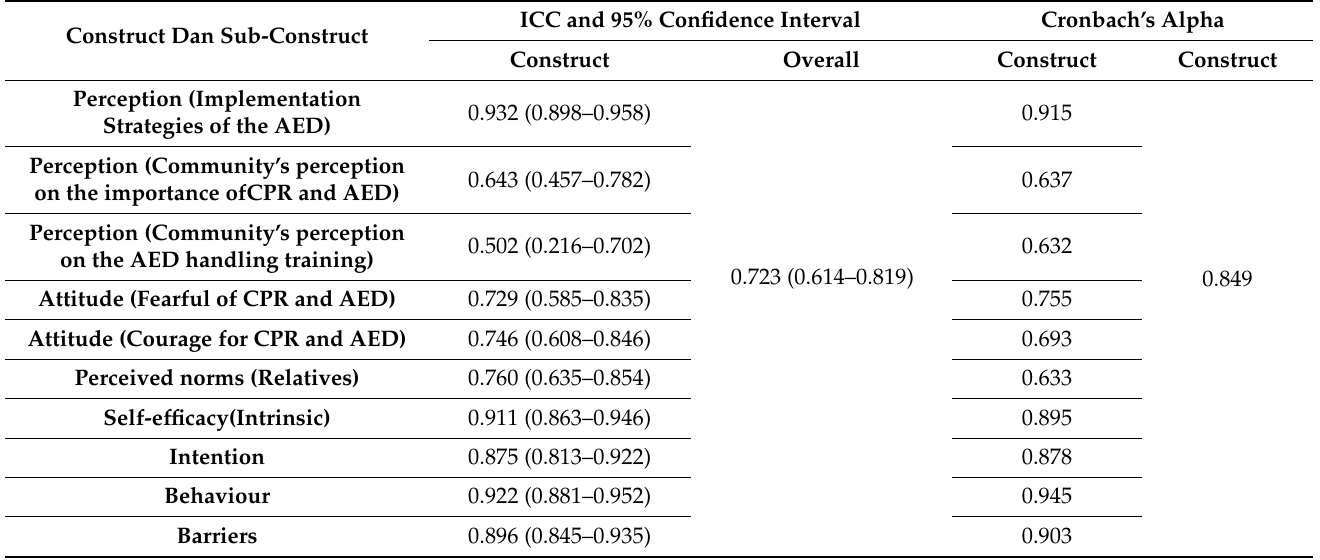
Table 6. Reliability of FIXED based on internal consistency and test–retest